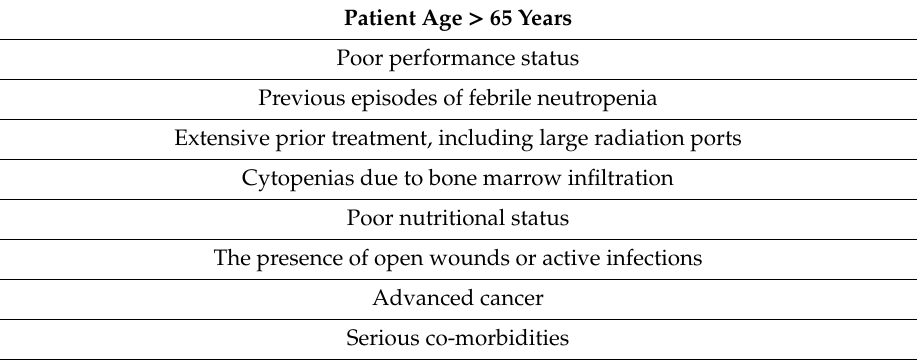
Table 2. Risk factors associated with development of febrile neutropenia associated with an overall risk of